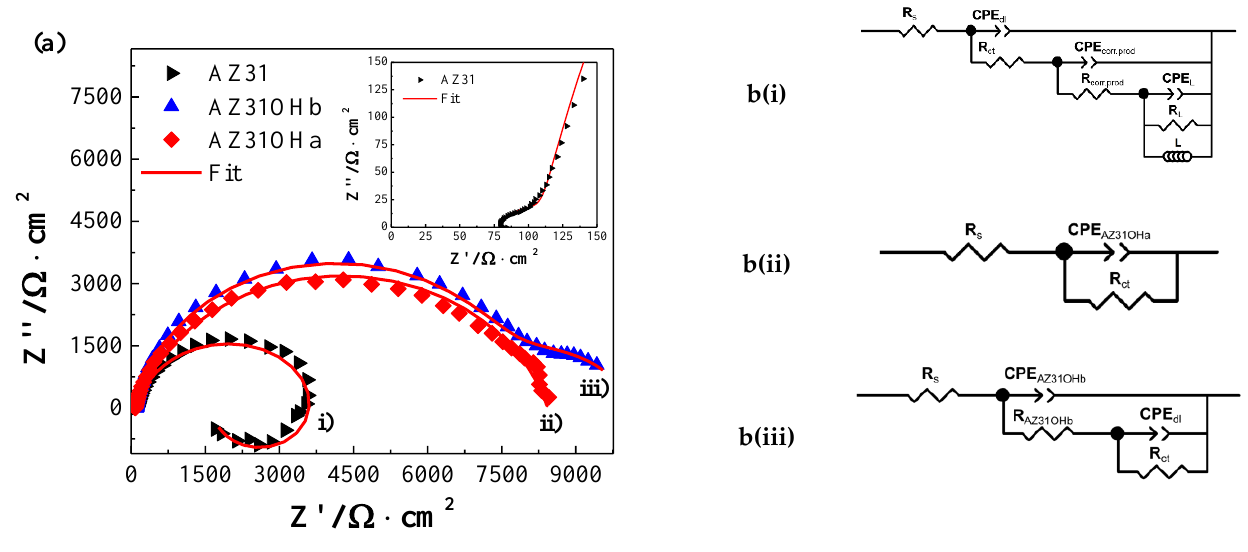
Figure 2. ( a ) EIS results for the AZ31 and anodised sample, polarizing 0.5 (AZ31OHa) and 1 h (AZ31OHb), respectively, using HBSS and ( b ) the equivalent circuits applied in the fitting. Table 4. Fitting parameters related to EIS spectra are shown in Figure 2. To understand the corrosion behaviour of AZ31, AZ31OHa, and AZ31OHb in the presence of the HBSS, Nyquist plots were analysed using EC-Lab software and fitted us- Sample ing an equivalent circuit to determine the values for each contribution. The equivalent circuits comprising a corrosion environment R s (electrolyte), resistance of the passive film (R film ), and resistance of charge transfer (R ct ) were estimated. AZ31 exhibited an induct- ance (L) associated with the redox reaction owing to the high reactivity of Mg. The CPE was used instead of a capacitive element, ( Υ CPE ( ω ) = 1/Z CPE = Q ( ϳ ω ) n ) the Υ admittance of the CPE, where ω is the angular frequency, Q is the modulus, and n is the phase deviation